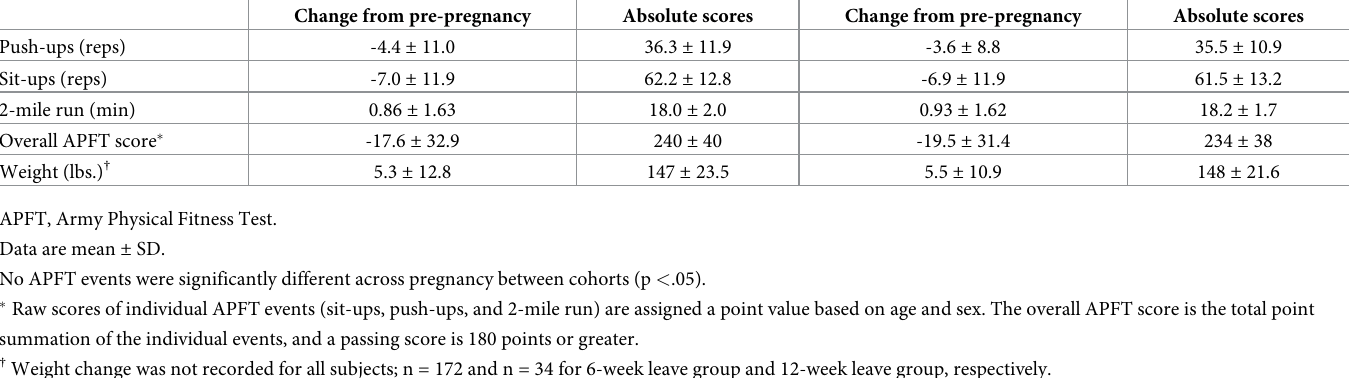
APFT. Time to APFTPOST was dichotomized as < 9 months vs. � 9 months after delivery and was not associated with postpartum performance on the APFT (Table 4). Multivariable logistic regression analysis showed that failure on APFTPOST was strongly associated with failure on APFTPRE, failure on pre-pregnancy BMI measurements, elevated BMI at 6 to 8-weeks post- partum, and never breastfeeding (Table 5).